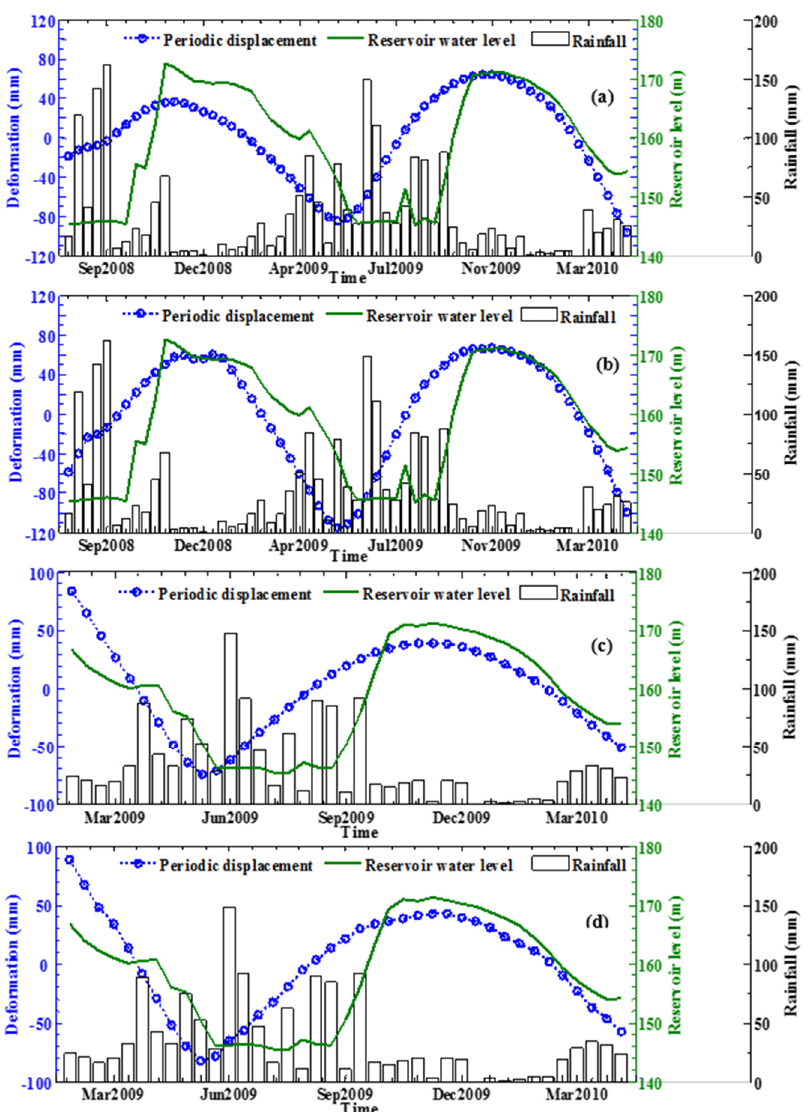
Figure 13. The periodic component of the SAR time-series derived from SM mode data in range ( a ) and azimuth ( b ) and that from HS mode data in range ( c ) and azimuth ( d ).